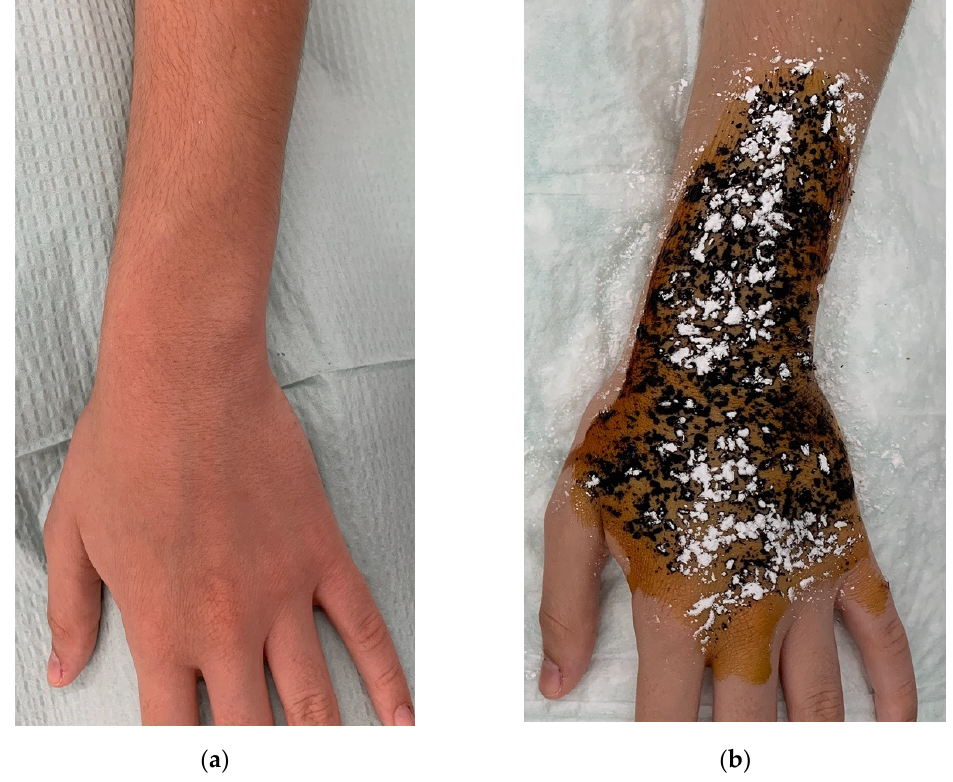
Figure 1. ( a ): Dorsal aspect of the patient’s left forearm, showing no clinically evident abnormalities. ( b ): Iodine-starch test (Minor’s test) highlighting the hyperhidrosis area. A punch biopsy was performed. The biopsy showed a slightly increased density of eccrine glands within the dermis, with no other abnormalities (Figure 2).